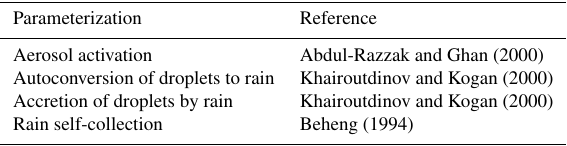
Table 2. CASIM microphysics scheme parameterization summary. Parameterization